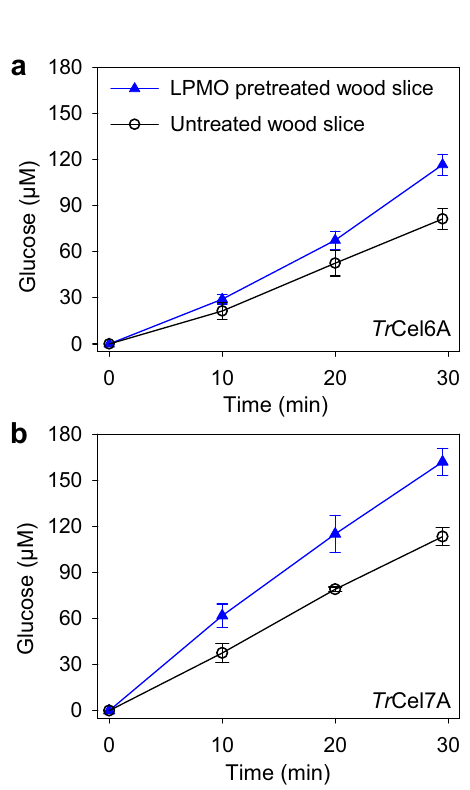
D633-labeled LPMO. c Image from bright fi eld microscopy shows the wood cell walls. d Anoverlayofboth fl uorescence channels shows the colocalization of CDH and LPMO. Picture size=measurement area=70×70 μ m.